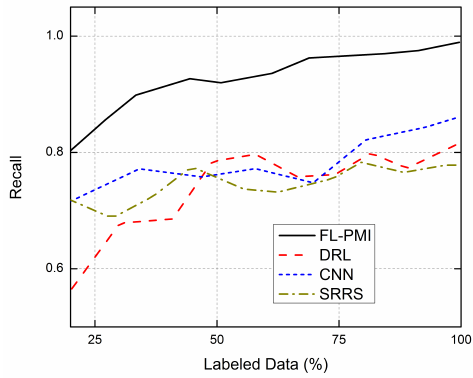
Figure 5. Analysis of auto-labelling in terms of